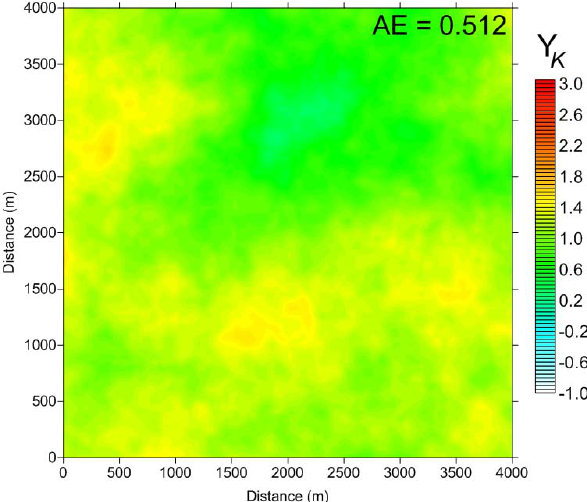
Figure 8. Frequency distribution of the ensemble of perturbed values for the observed WT value of 18.5 m collected on day 91 at location (X=2500 m, Y = 3500 m) of the “true aquifer”, for CV values of 0.10 and 0.30.